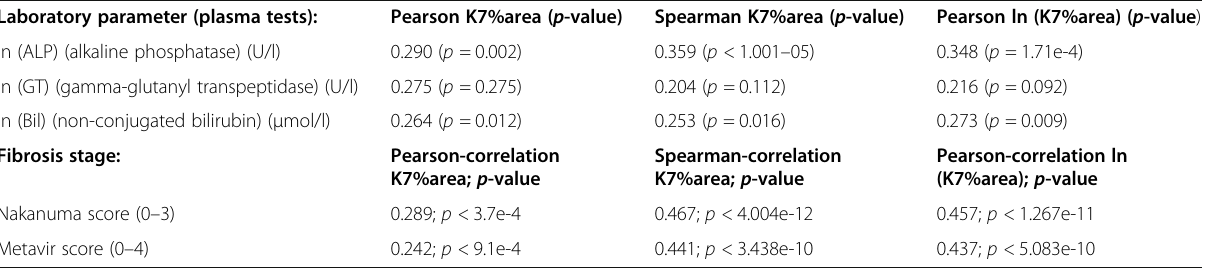
Table 4 The K7-AI model ’ s results (K7%area) and their correlations with biochemical examinations indicating cholestasis, and the K7- AI model results (K7%area and ln (K7%area)) in correlation with stage of fibrosis, according to Metavir and Nakanuma classifications Laboratory parameter (plasma